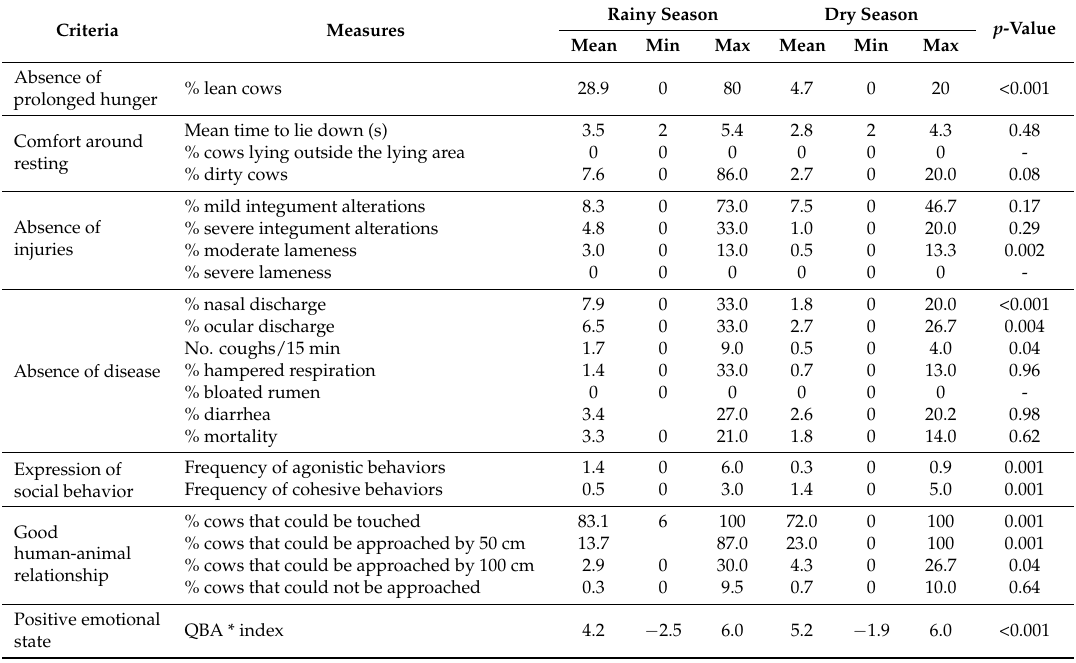
Table 3. Results of separate measures of the Welfare Quality ® assessment on 45 farms during the rainy